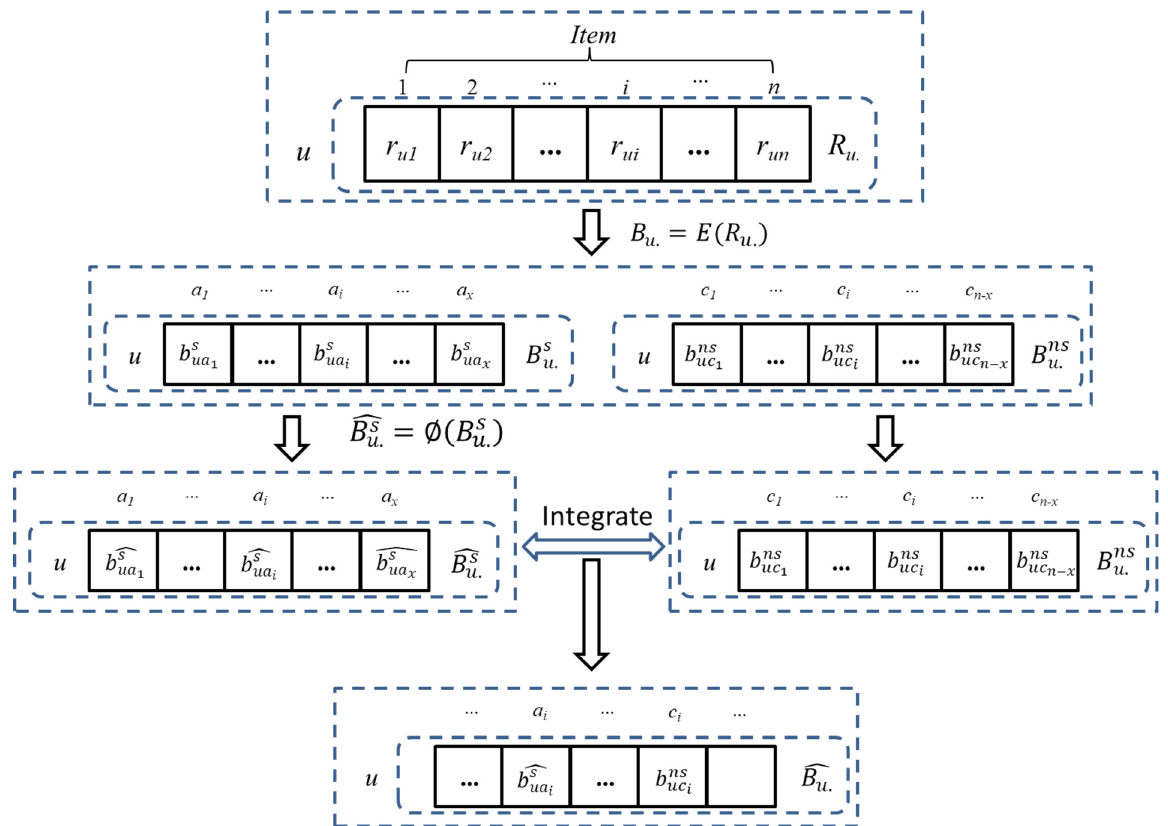
Figure 2. Privacy protection on rating data.